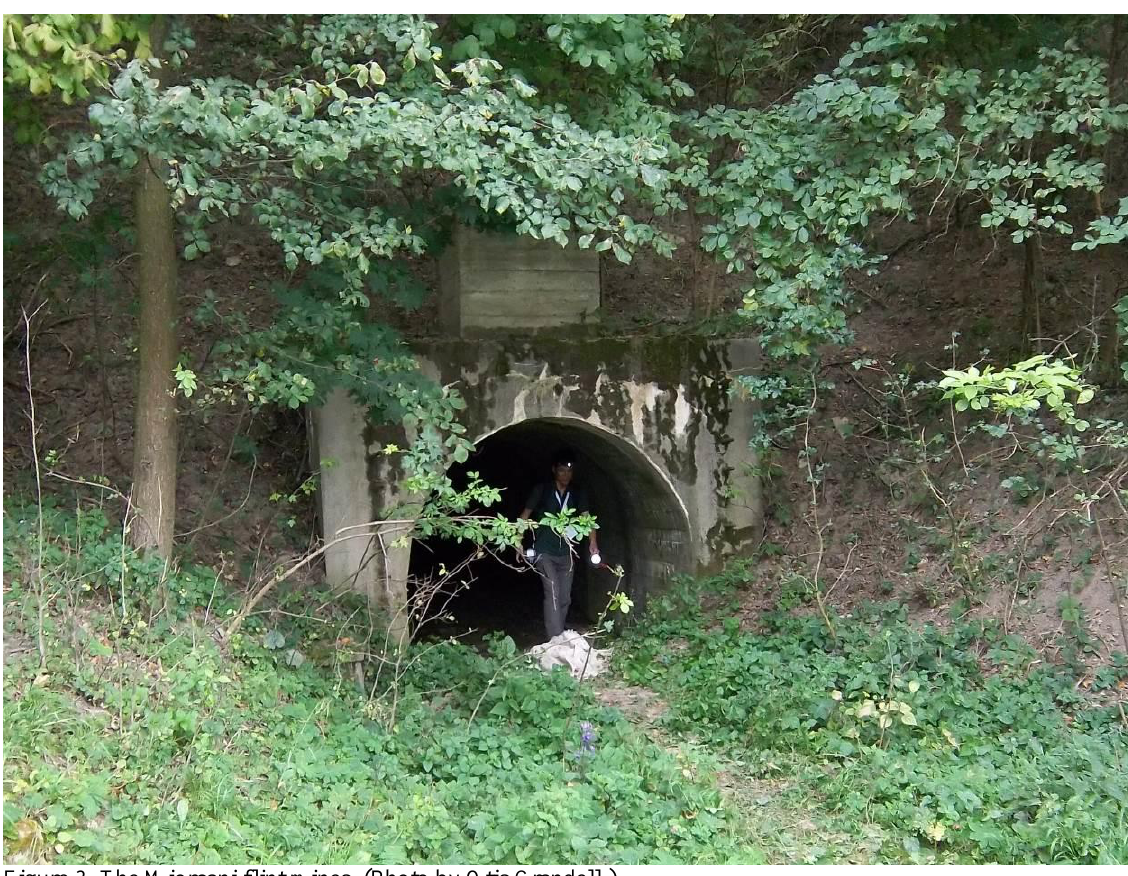
Figure 3. The Miorcani flint mines. (Photo by Otis Crandell.)